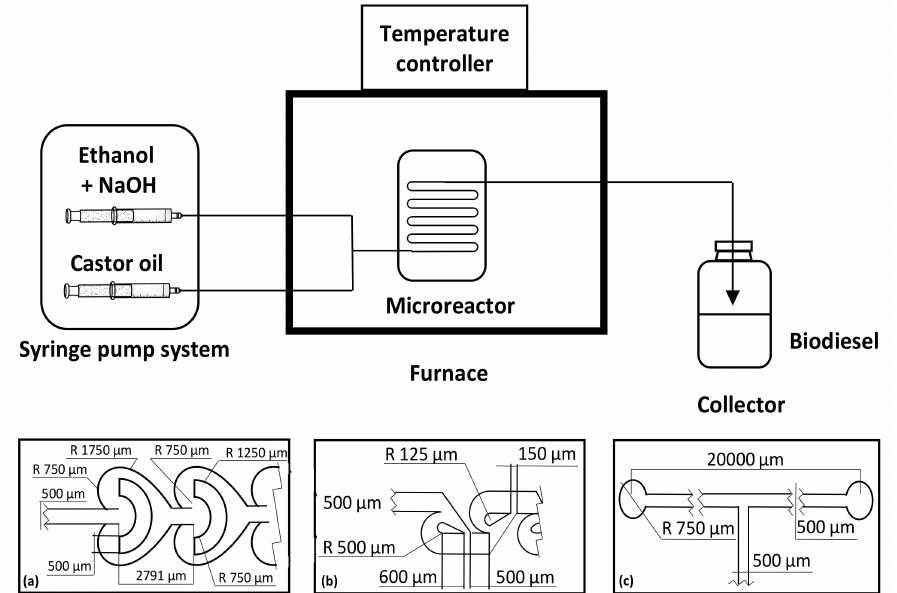
Figure 1. Transesterification reaction within ( a ) Omega shaped, ( b ) Tesla shaped and ( c ) t-shaped microreactors.